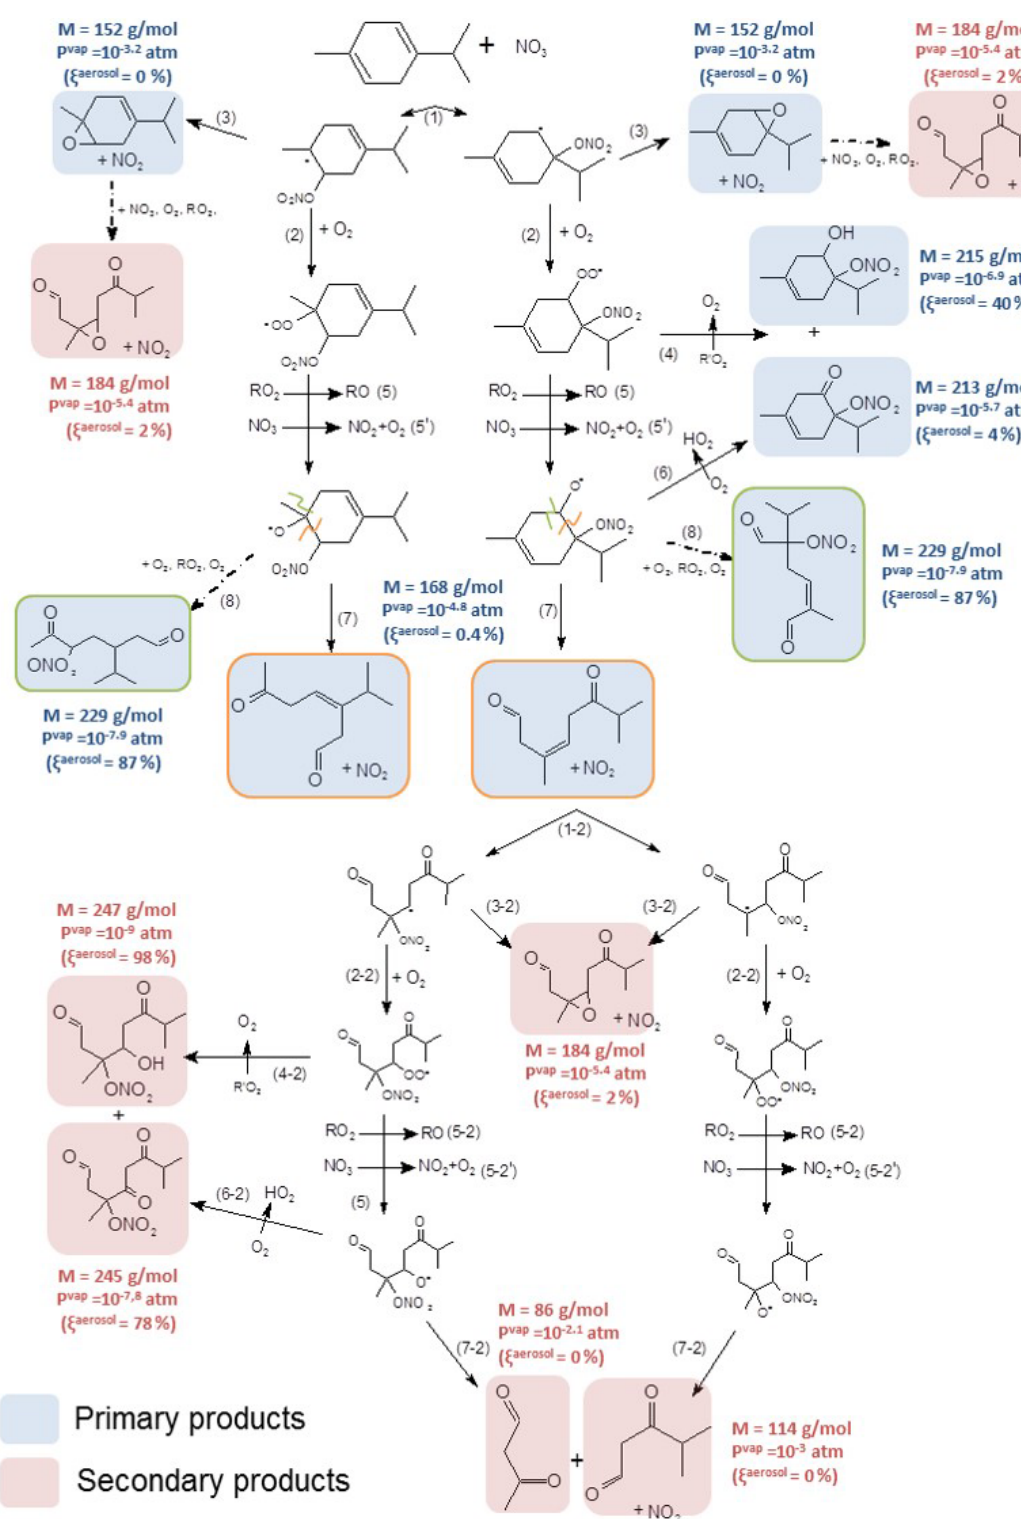
Figure 7. Proposed mechanism for γ -terpinene. First-generation products are in blue, and second-generation ones are in red. Alkoxy frag- mentation products are framed according to the location of the fragmentation. Molecular weight, vapor pressures and the gas–particle partition are shown next to the